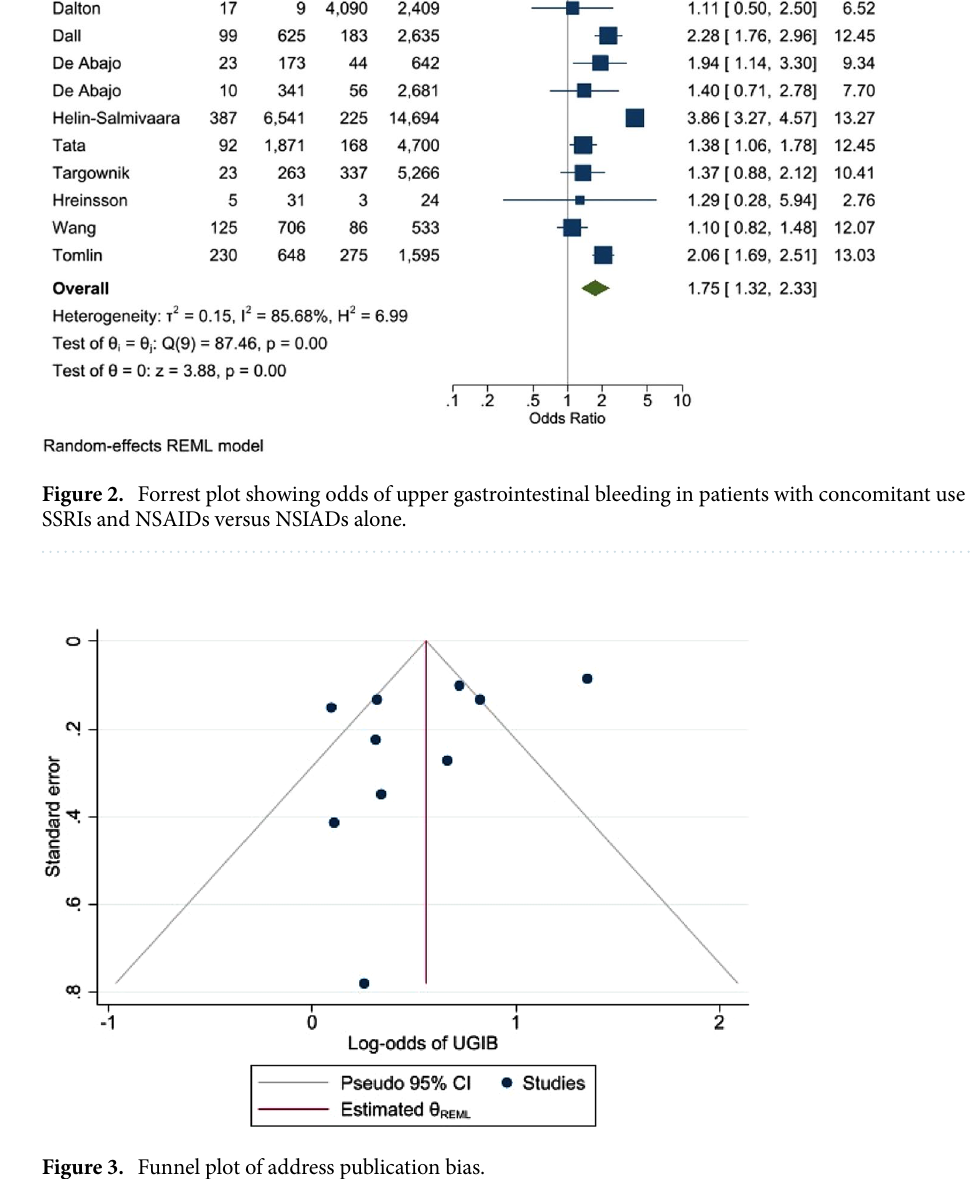
Figure 3. Funnel plot of address publication